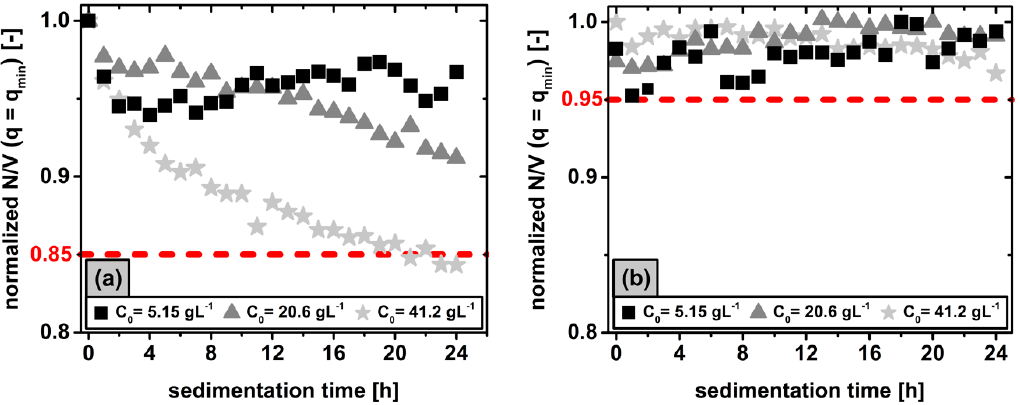
Figure 3. The relative N / V at constant q min = 0.00632 A − 1 of sterically stabilized AZO dispersions having initial concentrations in the range of 5.15 gL − 1 < C 0 < 41.2 gL − 1 is plotted over a sedimentation time period of 24 h before ( a ) and after ( b ) removing unstable phases using SAXS data.